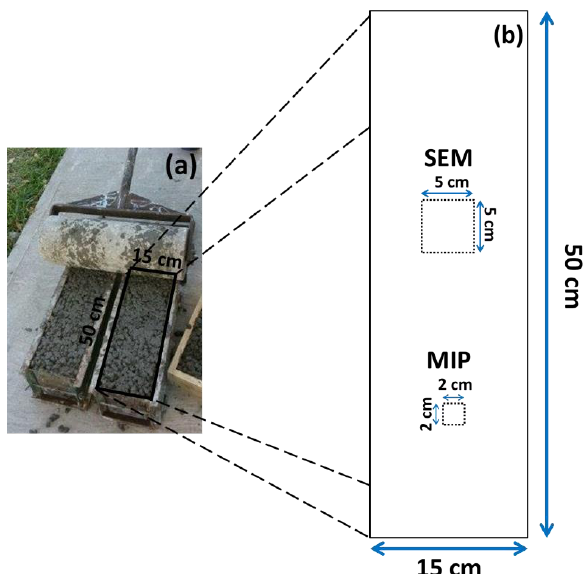
Figure 1. General scheme of the test samples. ( a ) real photo of the specimen beam and ( b ) areas of study for analysis of scanning electron microscope (SEM) and mercury intrusion porosimetry (MIP).